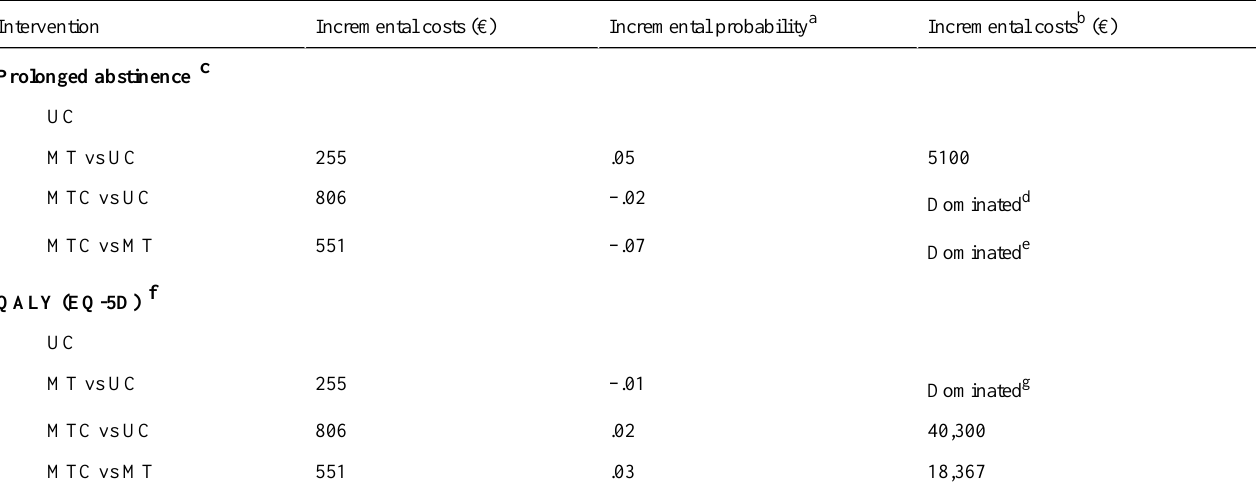
Table 4. Incremental costs and effects per abstinent smoker and per QALY gained for the MTC, MT, and UC groups with a willingness-to-pay threshold of